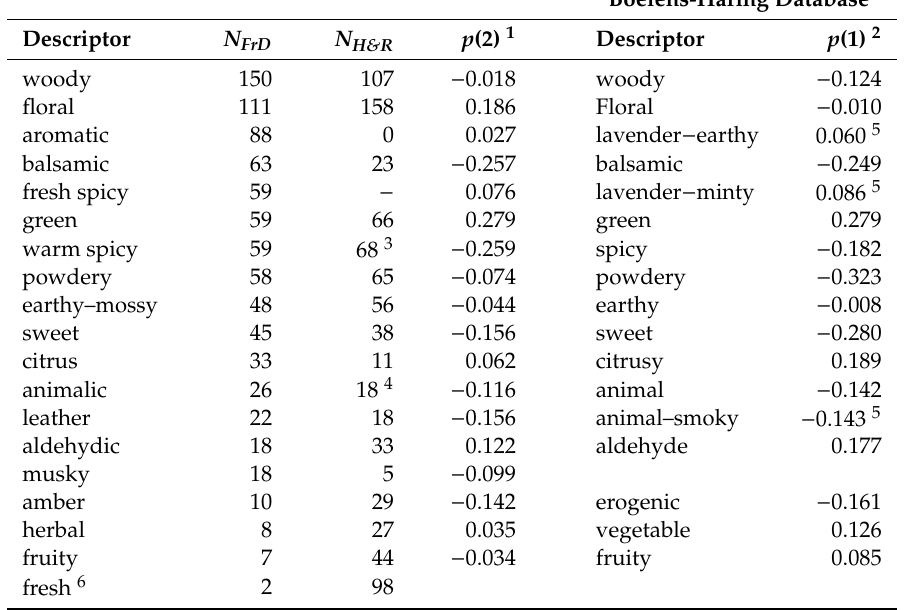
1 Values from Figure 2 (vertical axis). 2 PC1 loadings from the Boelens-Haring database (obtained from Figure 2 of Reference [30]). 3 The value corresponds to “spicy”. 4 The value corresponds to “sensual”. 5 Mean value